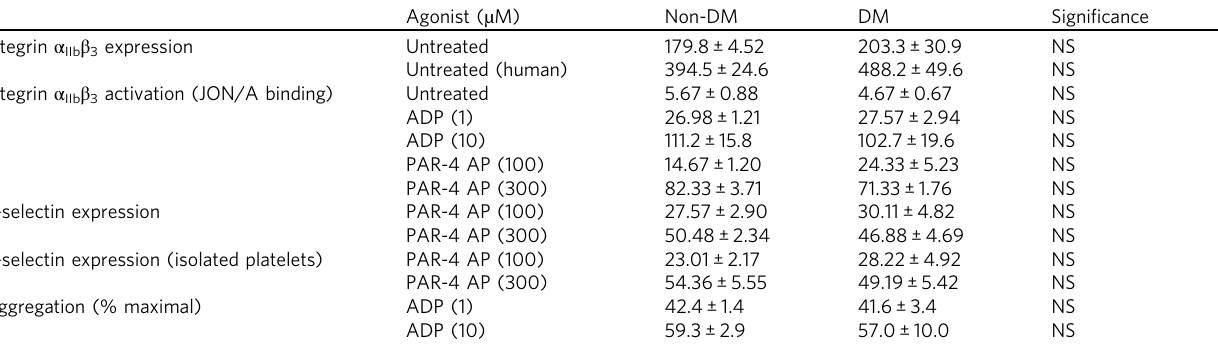
To assess integrin α IIb β 3 expression (Leo.F2 binding for mouse and HIP8 binding for human), activation (JON/A binding) and P-selectin expression in non-DM and DM platelets (mouse, if not stated otherwise),hirudinatedwholeblood(1/20diluted,ifnotstatedotherwise)orisolatedwashed plateletswerestimulatedwiththeindicatedconcentrationsofADPorPAR-4activatingpeptide(PAR4-AP) for10min,inthepresenceofPE-JON/AAborFITC-anti-P-selectinAb,respectively,thensubjectedto fl ow cytometry.Resultsareexpressedasthegeometricmeanof fl uorescenceintensity.Forplatelet aggregation, platelet rich plasma from non-DM and DM mice were subjected to aggregometry using 1 or 10 µ M ADP. Results are expressed as maximal extent of platelet aggregation (%). All results represent mean±s.e.m. of n ≥ 3 independent mouse experiments. For human results, n = 16 for non-DMs and n = 18 for DMs. NS = not signi fi cant, p ≥ 0.05. assessed using an unpaired, two-tailed Student ’ s t